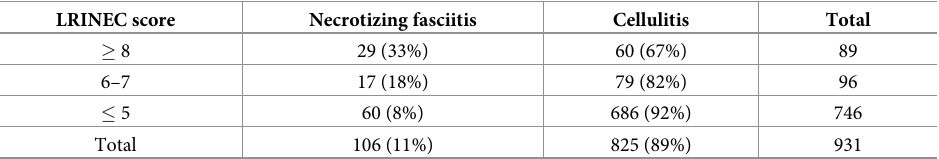
Table 2. LRINEC score with validation